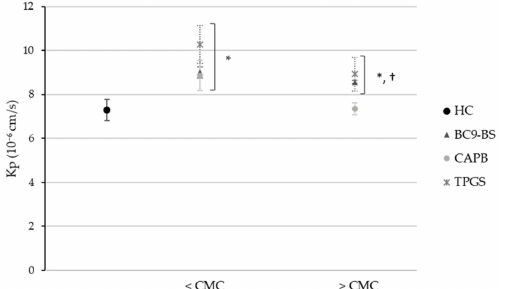
Figure 4. HC permeability across the PermeaPad ® barrier in the absence and presence of surfac- tants at concentrations below (<) and above (>) their CMC. Data are expressed as means ± SD, n = 3. Significance indicated by * = p < 0.05 with respect to Kp of HC without surfactants, and by † = p < 0.05 compared to Kp of HC in presence of CAPB >